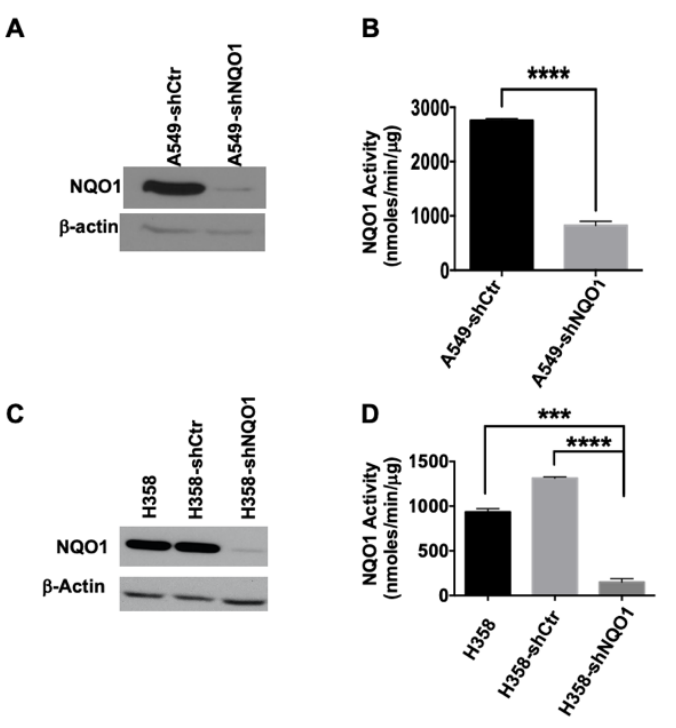
Figure 2. Stable knockdown of NQO1 expression in NSCLC cells reduces NQO1 activity. In ( A ), A549 lung adenocarcinoma cells were evaluated for NQO1 expression following retroviral transduction of shRNA targeted at NQO1 (A549-shNQO1), or empty vector control (A549-shCtr). In ( B ), A549-shCtr and A549-shNQO1 cell lines were analyzed for NQO1 activity, where loss of NQO1 protein expression correlated with a significant decrease in NQO1 activity (**** p < 0.0001). In ( C ), the lung cancer cell line, H358 was evaluated for NQO1 protein expression following retroviral transduction of shRNA directed toward NQO1 (H358-shNQO1), or the empty vector control (H358-shCtr). In ( D ), H358-shCtr and H358-shNQO1 cell lines were evaluated for NQO1 activity and demonstrated that loss of NQO1 protein expression correlated with a significant decrease in NQO1 activity (**** p < 0.0001; *** p <